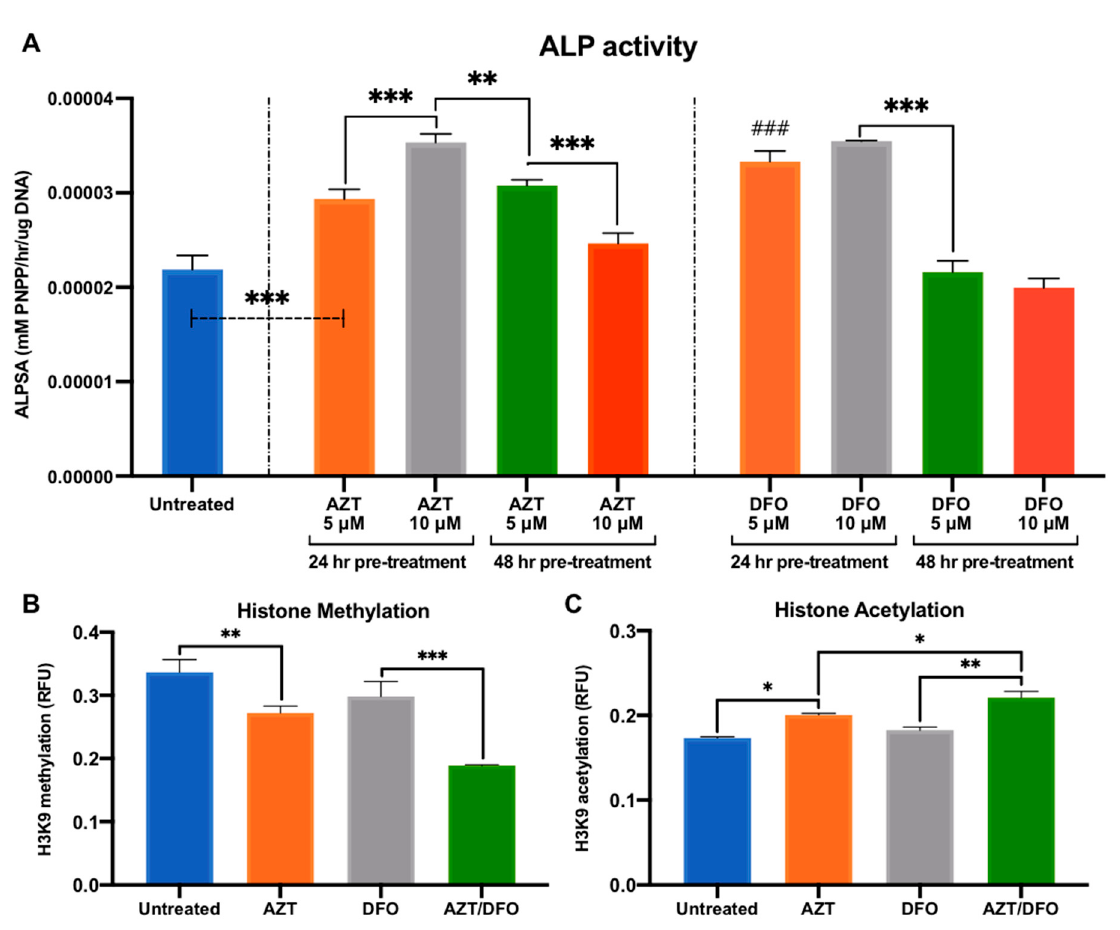
Figure 3. The effect of AZT/DFO pre-treatment on ALP activity and epigenetic function in hBMSCs. ( A ) ALP activity in hBMSCs pre-treated with AZT and DFO for 24 or 48 h followed by 14 days osteoinductive culture. The effect of AZT/DFO pre-treatment on hBMSC ( B ) histone methylation and ( C ) histone acetylation levels following 3 days in basal conditions. Data are expressed as mean ± SD ( n = 3). * p ≤ 0.05, ** p ≤ 0.01 and *** p ≤ 0.001. ### p ≤ 0.001 vs. untreated control.